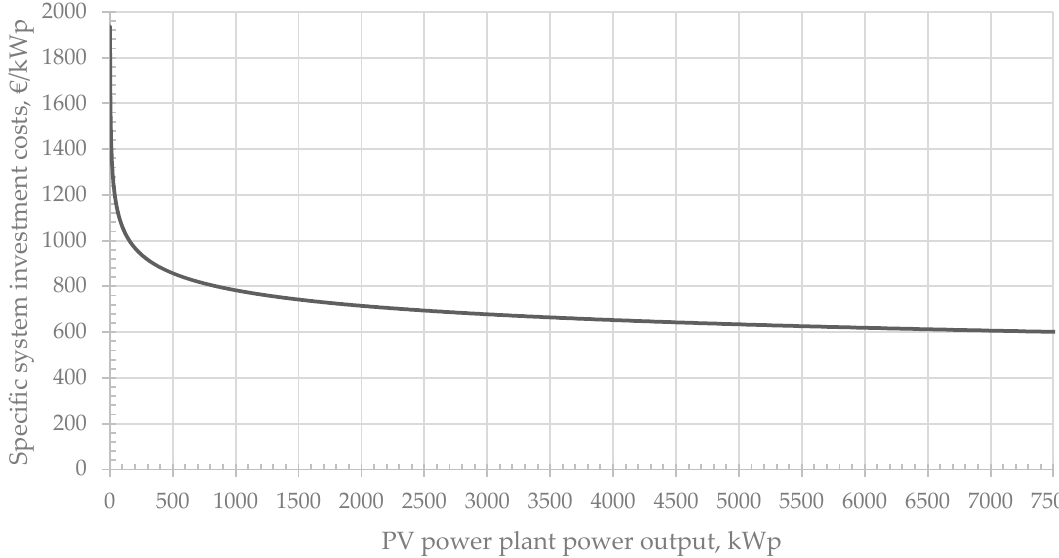
Figure 1. Photovoltaic (PV) system investment costs excl. value added tax (VAT) (Source of data: [1,36]); source of figure: Energieinstitut an der JKU).